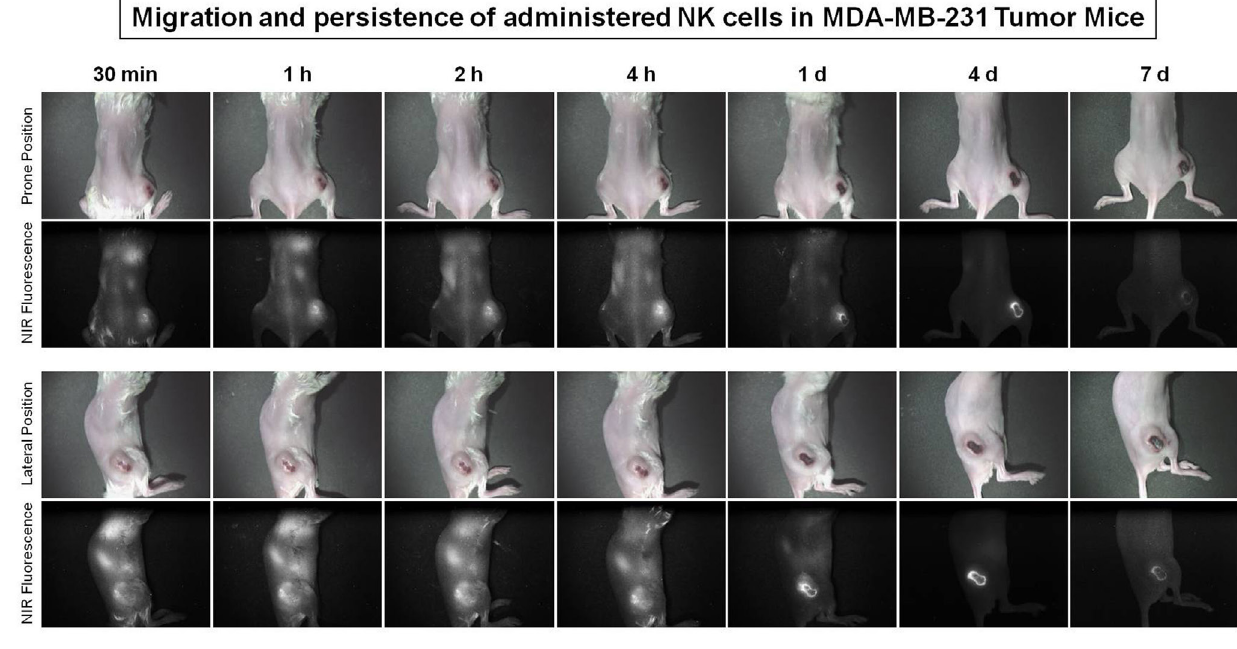
FigUre 7 | Migration of natural killer (NK) cells toward primary tumor sites in human breast cancer xenograft models. The MDA-MB-231 tumor-bearing mice (31 days after tumor injection) were used to investigate the trafficking of expanded human NK cells. Expanded NK cells were stained with ESNF13 dye and injected into MDA-MB-231 tumor-bearing NSG mice by intravenous. The fluorescent signal was visualized using a near-infrared (NIR) fluorescent system until day 7